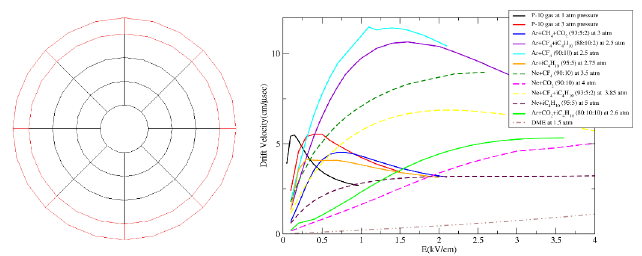
Figure 2. (Left) Segmented anode pad as designed in Geant4 simulation. (Right) Electron drift velocity as a function of field for various gas mixtures obtained using